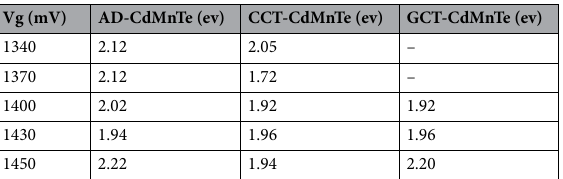
Table 1. Bandgap of the CdMnTe layers electrodeposited at different growth voltage (Vg) and post-growth treatments.